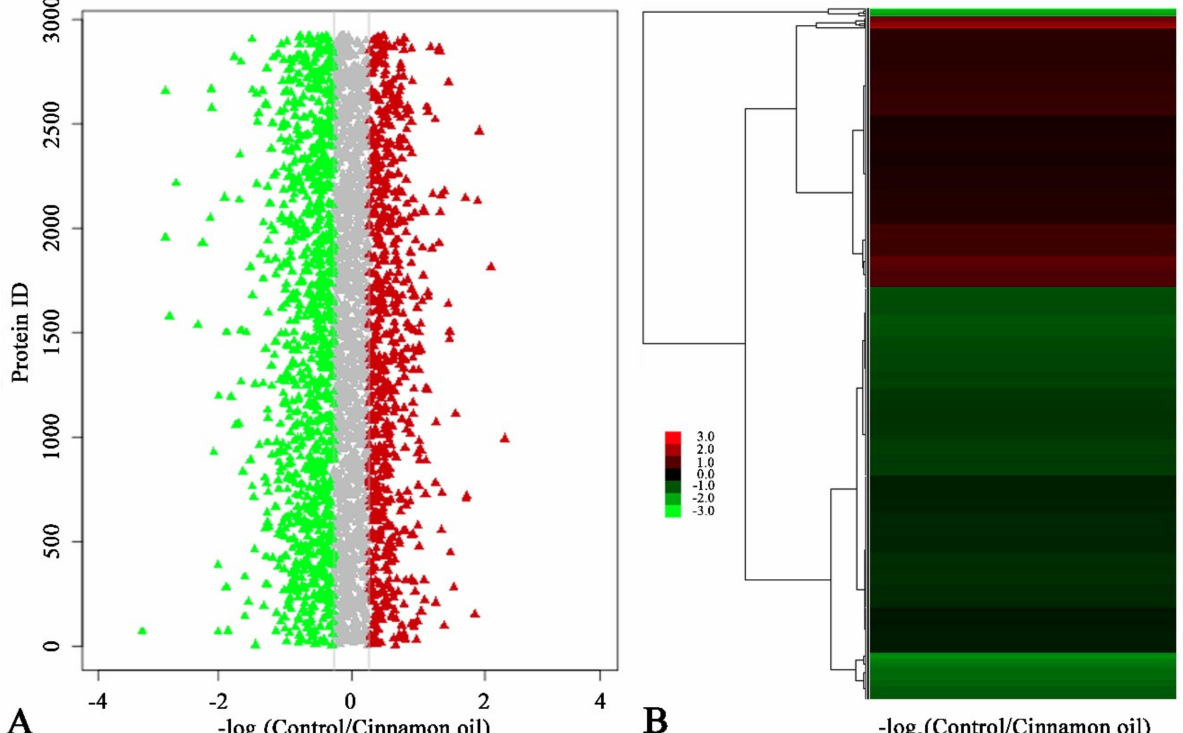
Figure 3. ( A ) Ratio distribution of identified proteins in control and cinnamon oil-treated spores after 6 h of culture. Red, gray, and green triangles represent up-regulated, non-regulated, and down-regulated proteins, respectively. ( B ) Heatmap of the ratio of identified proteins in control and cinnamon oil-treated spores after 6 h of culture. Gradient color barcode (red to green) indicates the up-regulation to down-regulation of protein expression. Each row represents a protein. Proteins with similar fold change values are clustered at the column level. The detailed original data for ( A , B ) are listed in Table